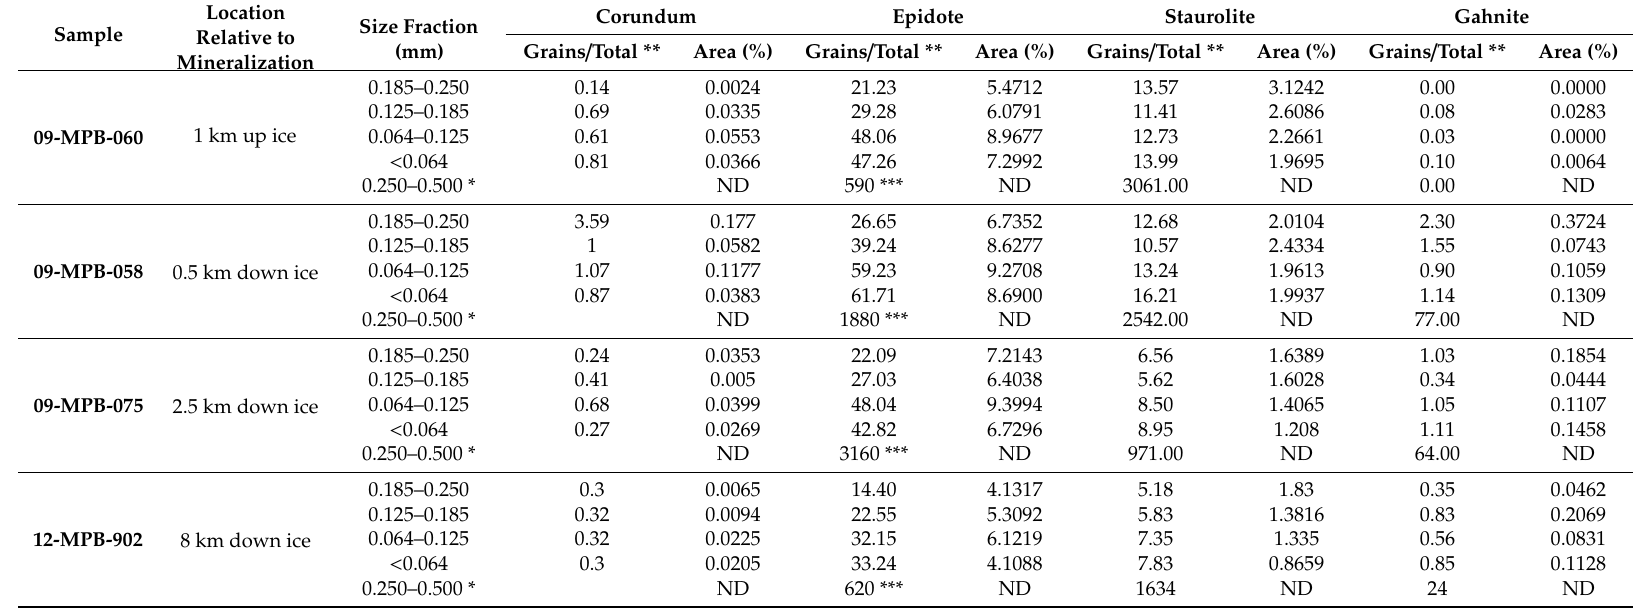
Table 4. Abundance of alteration indicator minerals in four till sample up- and down ice of the Izok Lake VMS deposit. Mineral abundance data are reported in two di ff erent ways: (1) number of indicator mineral grains per 1000 grains; (2) minerals by 2-dimensional percentage area they take up on the polished mount surface. Grey-shaded values are grain counts from the coarse (250 to 500 µ m) heavy mineral fraction of the same sample obtained by visual grain picking that have been normalized to a 10 kg of sample mass (data from Hicken et al.